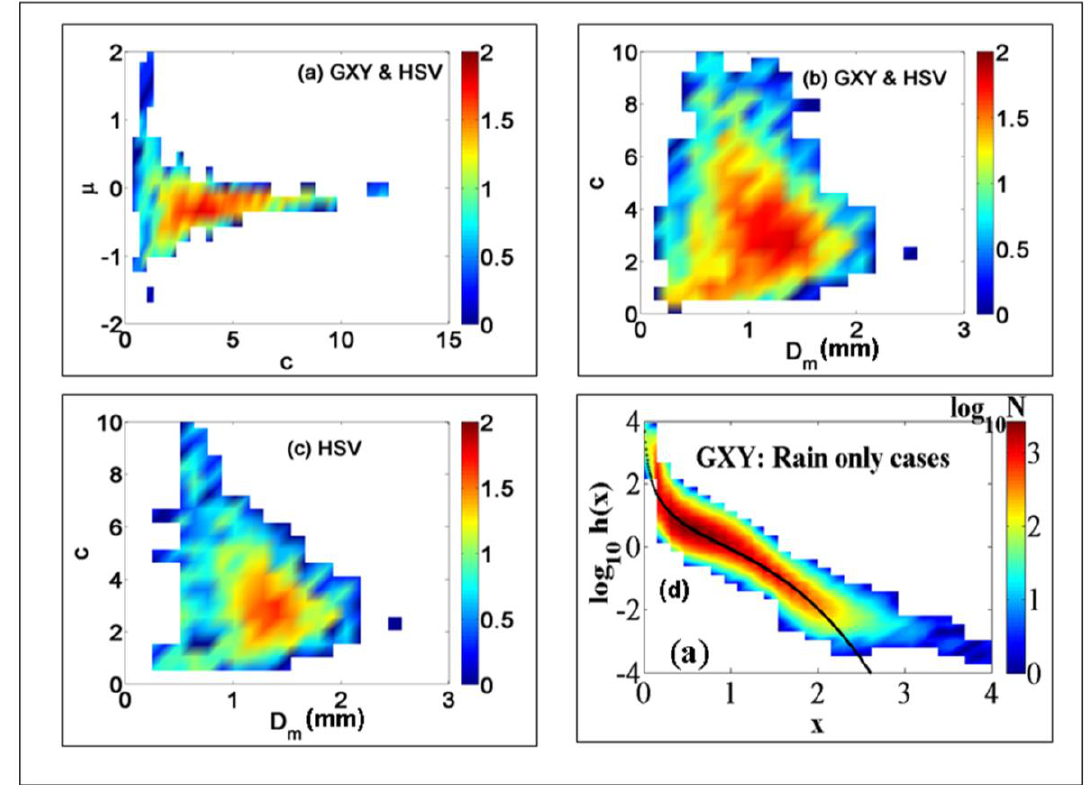
Figure 7. ( a ) Color intensity plot of the fitted values of µ versus c from all events from GXY and HSV; ( b ) same as (a) but for the fitted c versus D m ; ( c ) same as ( b ) but for HSV events only; ( d ) h ( x ) versus x in terms of frequency of occurrence (color) and the most probable variation shown as a black curve.